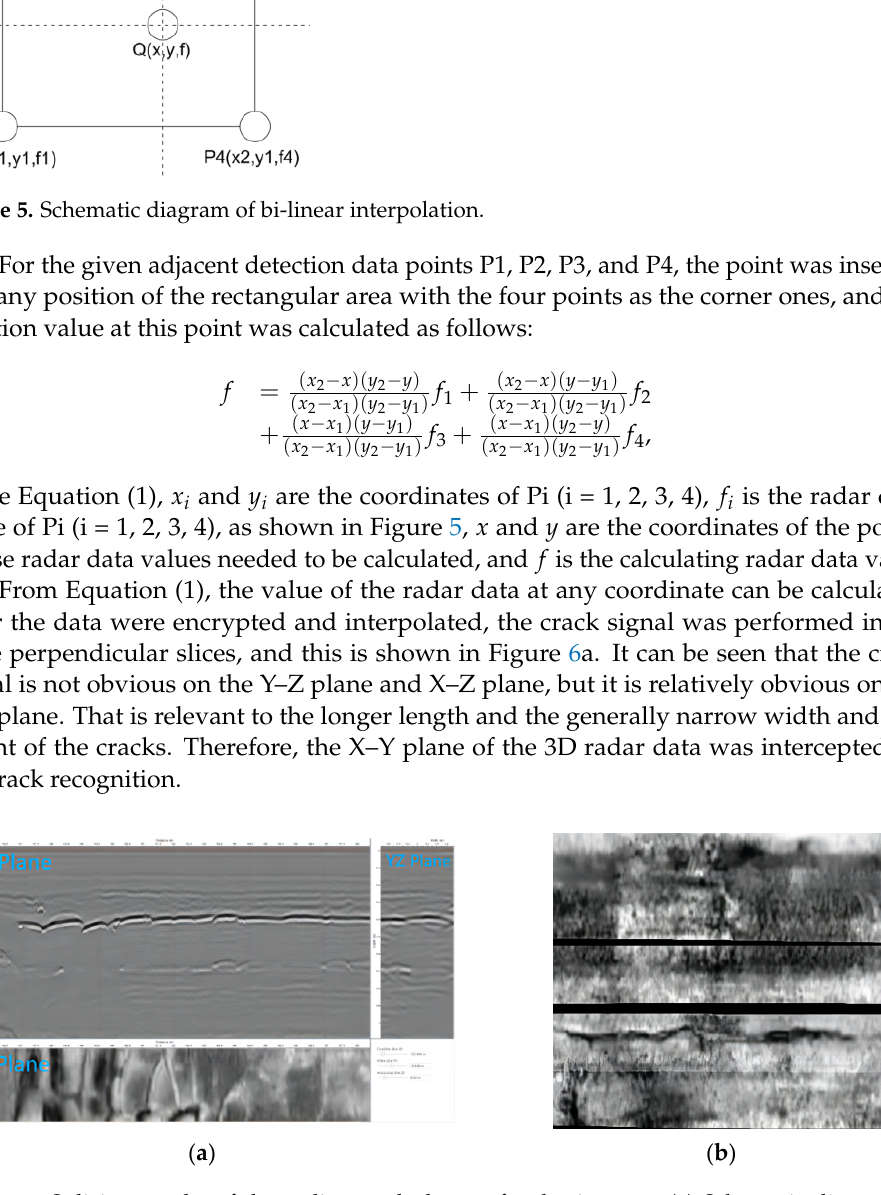
Figure 6. Splicing results of three slices and planes of radar images. ( a ) Schematic diagram of X–Y section, Y–X section, and X–Z section. ( b ) Mosaic image of multiple test lanes on X–Y section.